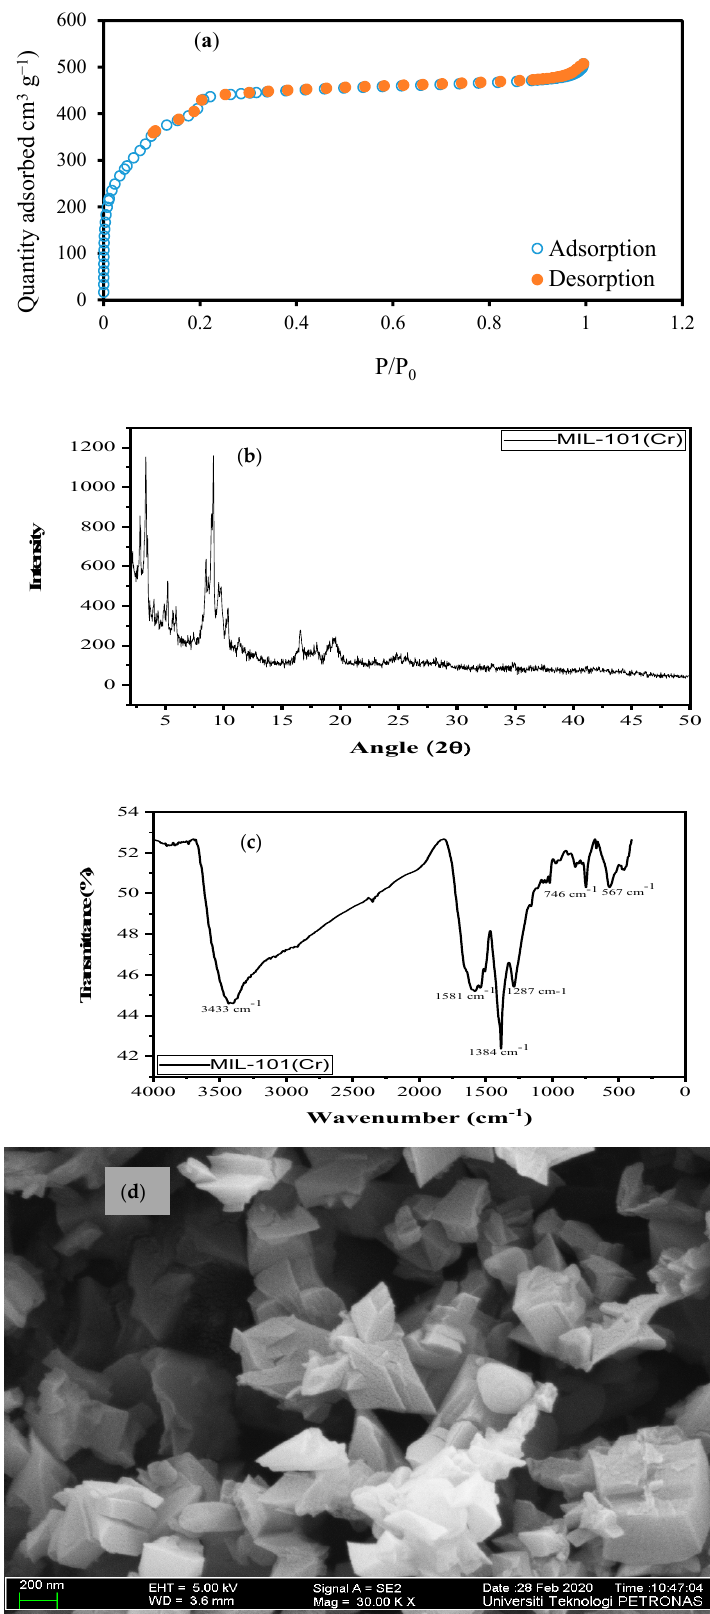
Figure 1. Characterization of the MOF ( a ) N 2 adsorption − desorption isotherm, ( b ) XRD pattern, and ( c ) FTIR spectrum ( d ) FESEM spectrum of MIL-101(Cr).